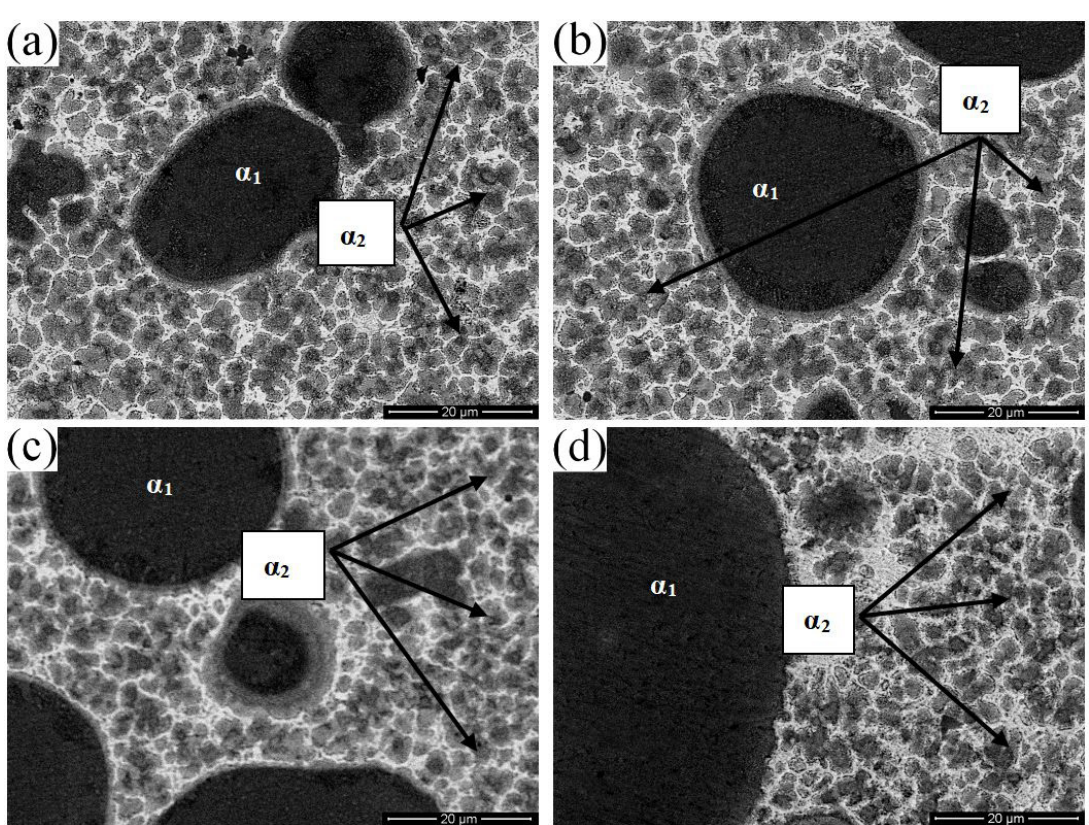
Figure 9. SEM images of rheo-diecasting by SIM under different holding time (a) 0min; (b) 3min; (c) 5min and (d) 10min.